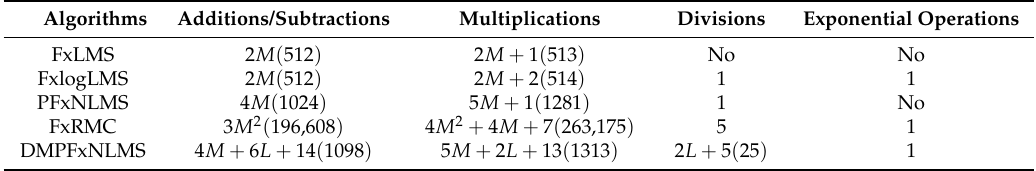
Table 2. Computational complexity of the mentioned algorithms in one iteration. ( M = 256, L =